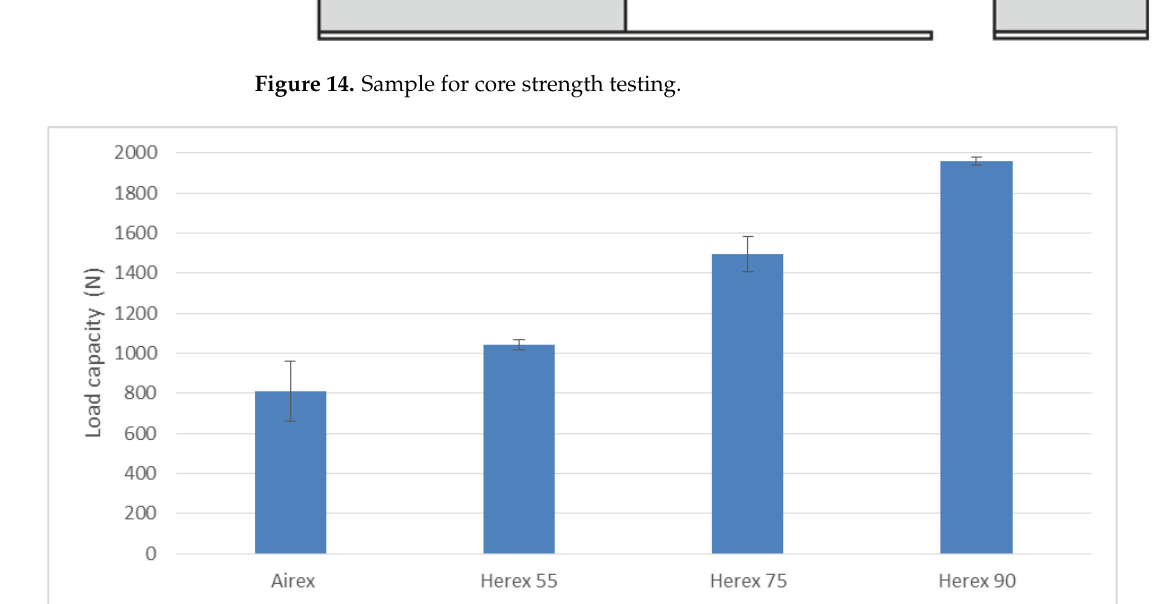
Figure 15. Load capacity of the core or the adhesive joint between the core and the face in the tested composites.